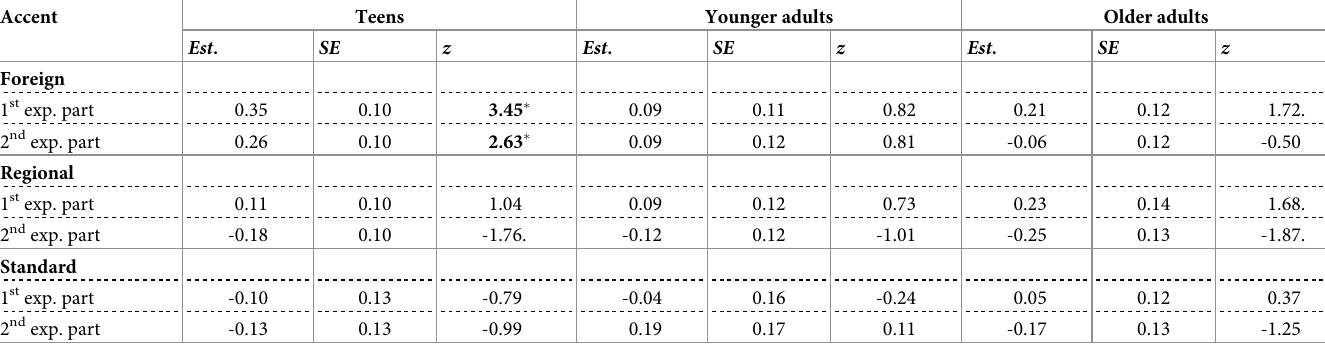
Pairwise contrasts for sentence repetition accuracy between Asian and white European ethnicity within each group, accent context, and experimental part. Coefficients (Est.), standard errors (SE), and z-values were extracted from the mixed effect logistic regression model (Tukey-adjusted for multiple comparisons). Positive estimates indicate the extent to which intelligibility was higher for Asian ethnicity than white European ethnicity. � p < .05, . p <